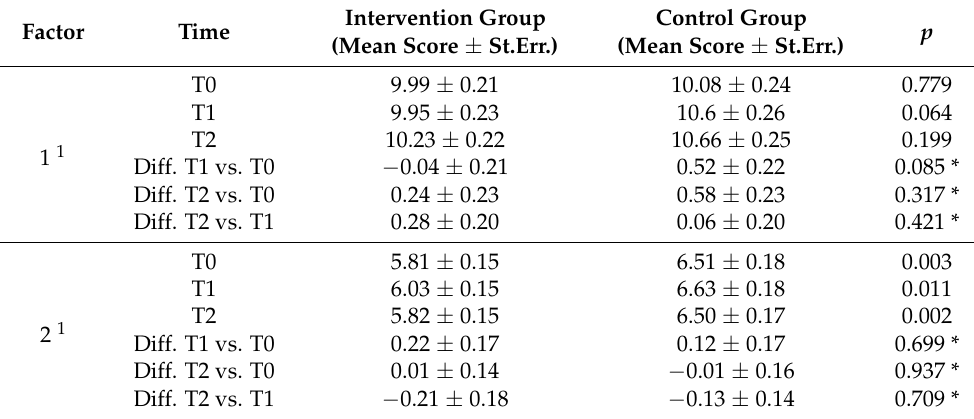
Table 2. Questionnaire A. Effect of nutrition education on eating habits and attitude towards food by